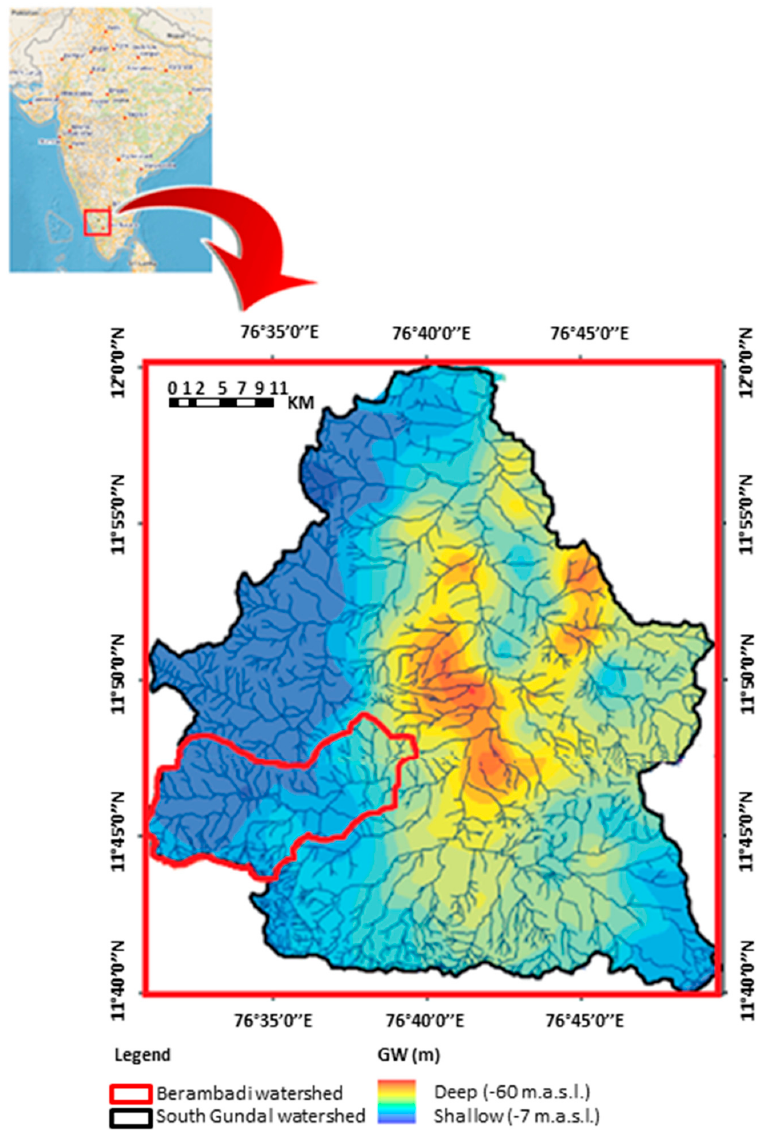
Figure 1. Location of the case study. The Berambadi watershed belongs to the South Gundal watershed located in southern Karnataka state. GW is the ground water level below ground (m). The GW level comes from extrapolation of data measured on 600 disused borewells at the end of 2012 monsoon.